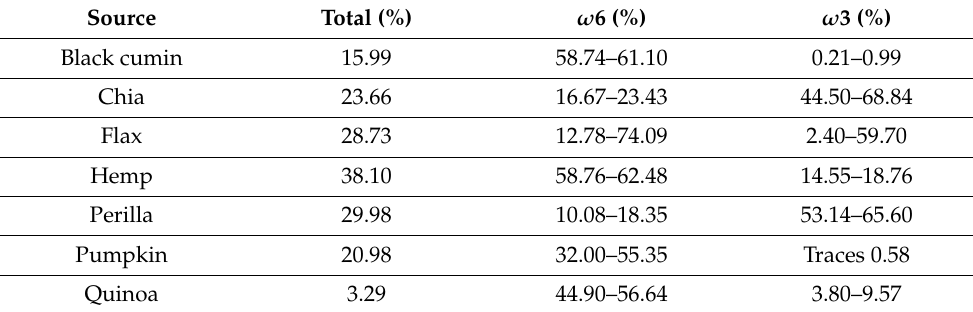
Table 3. Most common plant sources and their PUFA content ( ω 6 and ω 3)